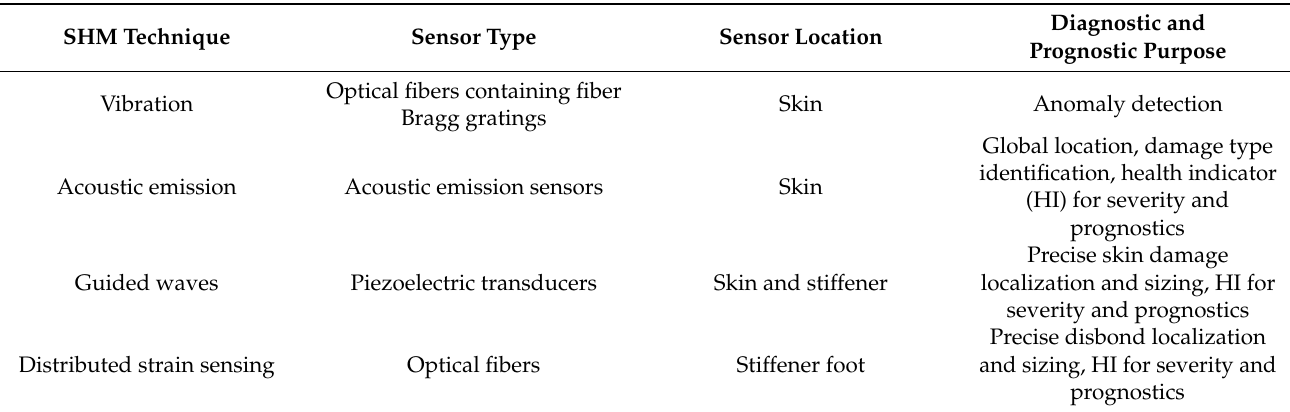
Table 2. SHM techniques employed for damage state assessment of multi-stiffener composite aircraft wing